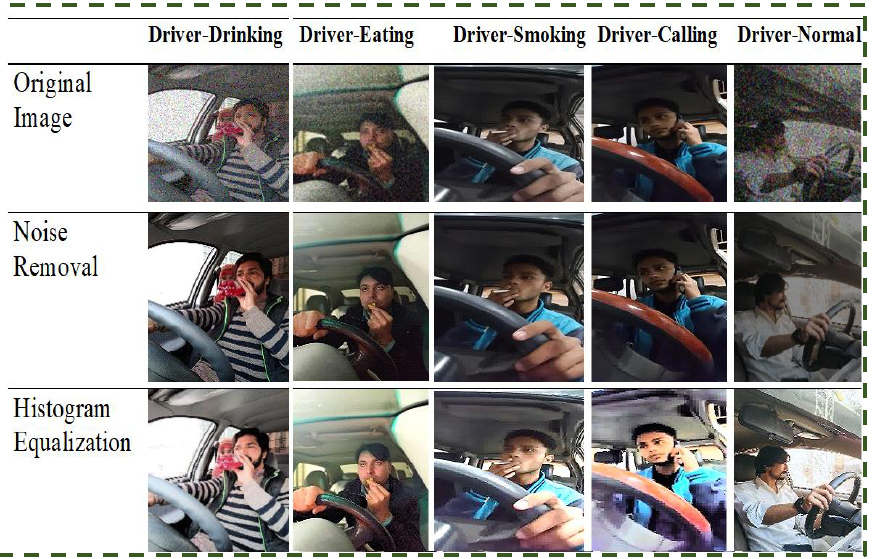
Figure 3. Some raw images with pre-processed images.